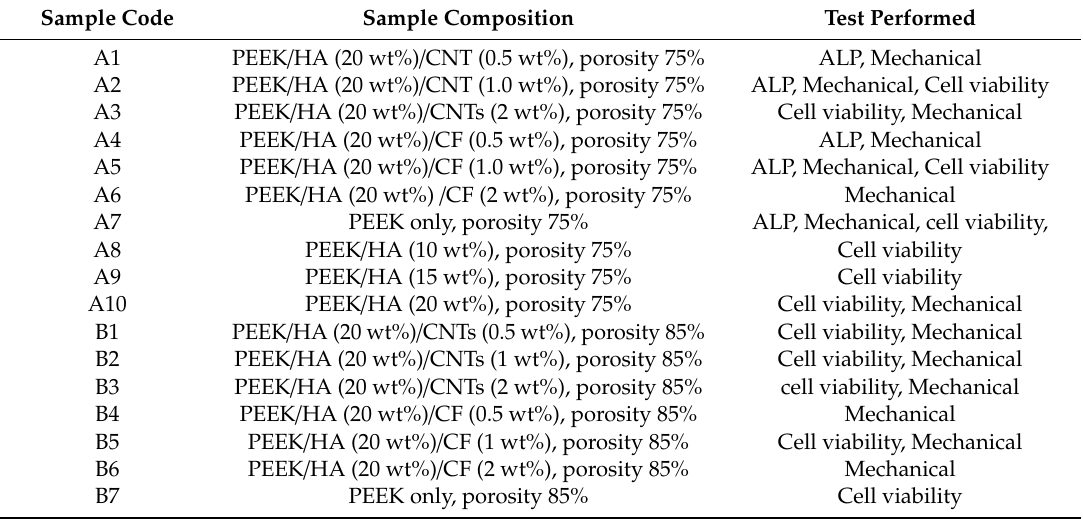
Table 1. Bionanocomposite samples’ codes, compositions, and various tests performed in the study. Sample